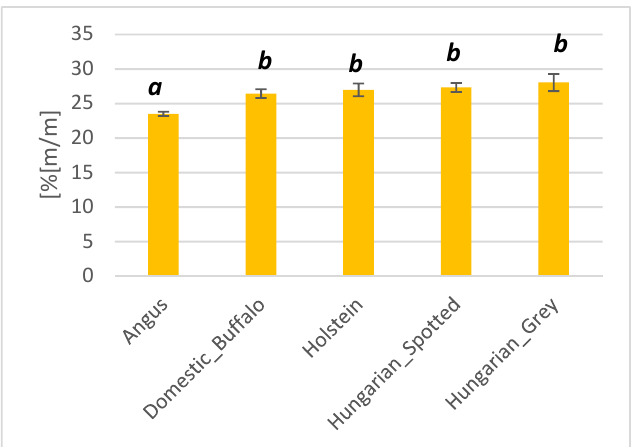
Figure 6. Bar plot showing the dry matter content of Angus, domestic buffalo, Holstein, Hungarian Spotted, and Hungarian Grey bovine breeds. Different superscripts imply significant differences.